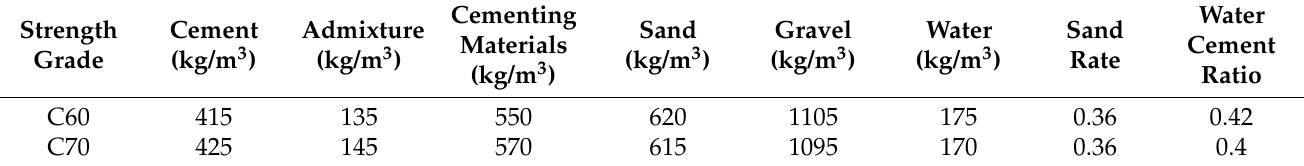
Table 1. Mixture proportions of C60 and C70 high-strength concrete.